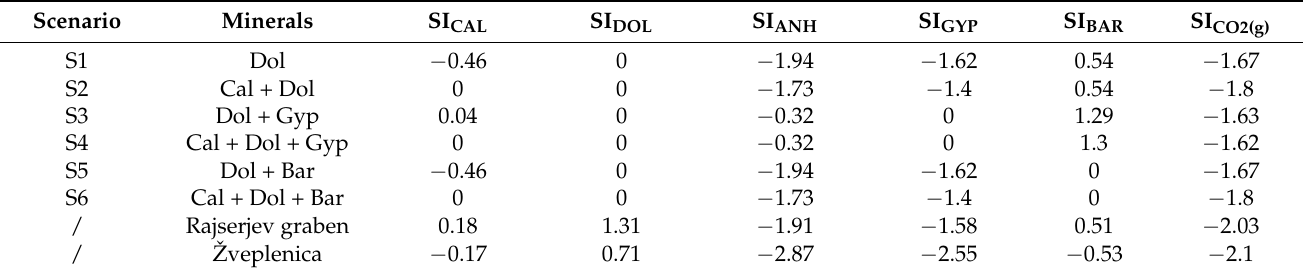
Table 2. Six PHREEQC scenarios (S1 to S6) and spring data with calculated saturation indices for calcite, dolomite, anhydrite and gypsum, and partial pressure of CO 2 gas, given as 10 SI bar. Saturation indices of these minerals and CO 2 (g) are also presented for the speciation of Žvepovnik groundwater. Data for the Žveplenica spring are taken from Zega et al.